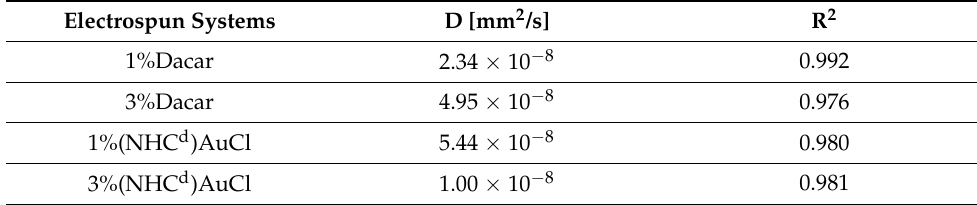
Table 4. Diffusive parameters for diffusive electrospun systems. Electrospun Systems